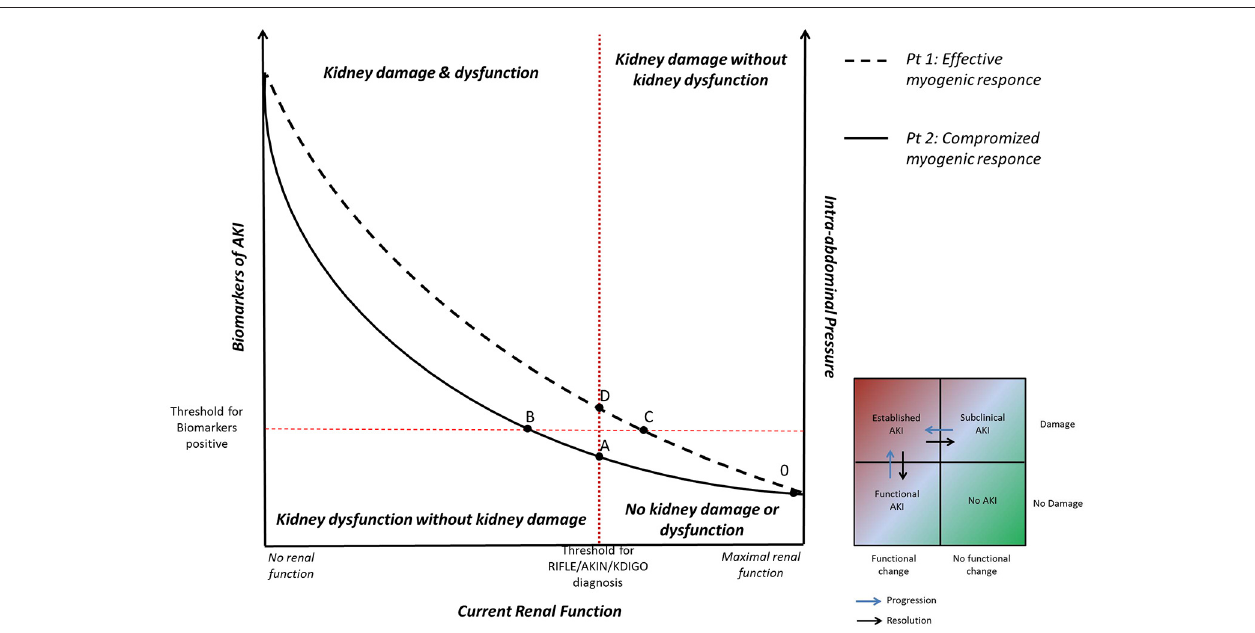
FIGURE 1 | Correlation between current renal function, intra-abdominal pressure (IAP), and biomarkers of acute kidney injury (AKI). Patient n ◦ 1 (dashed line): in presence of effective myogenic response, an acute increase in IAP is associated to a slight decrease in renal function (tract 0–C). A further increase of IAP may lead to biomarkers increase (subclinical AKI, tract C–D). When IAP overcomes the intrarenal autoregulation, glomerular hypoperfusion occurs and a picture of clinical AKI becomes manifest (above point D). Patient n ◦ 2 (solid line): in presence of compromised myogenic response, an acute increase in IAP is associated with a strong reduction in renal function until the development of clinical functional AKI (tract A–B). If IAP further increases, the inflammatory and ischemic insults may lead to the kidney parenchymal damage detectable by biomarkers (above point